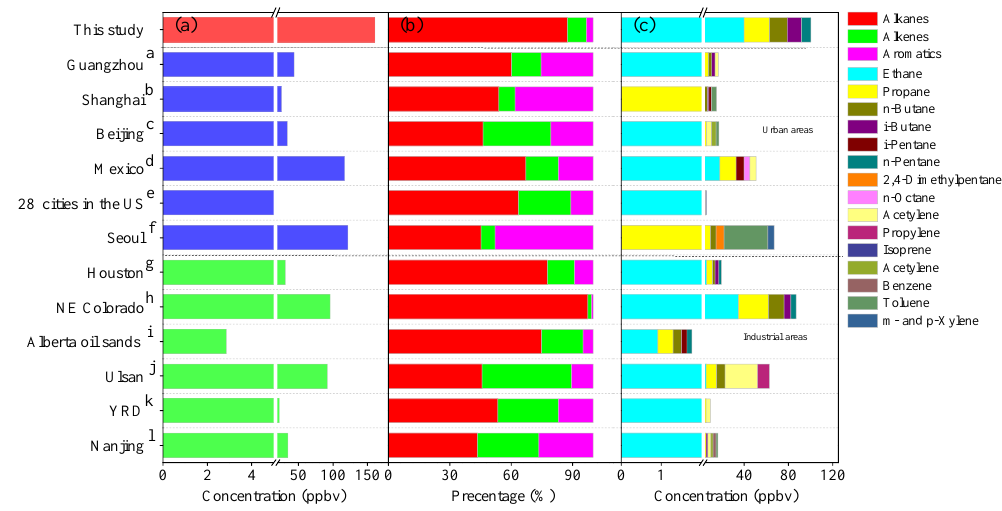
Figure 4. Comparison of the VOC concentrations (a) , compositions (b) and the top five VOC species (c) in this study with former studies concerning the VOCs in ambient air of urban and industrial areas. a Zou et al. (2015). b Cai et al. (2010). c Wang et al. (2010). d Garzón et al. (2015). e Baker et al. (2008). f Na and Kim (2001). g Leuchner and Rappenglück (2010). h Gilman et al. (2013). i Simpson et al. (2010).